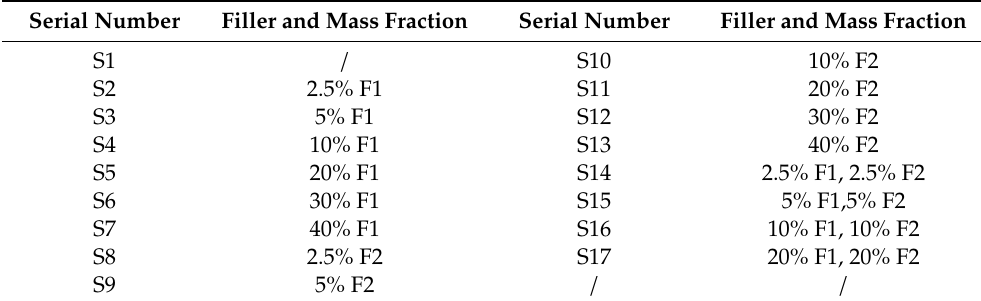
Table 1. Sample serial number and type comparison